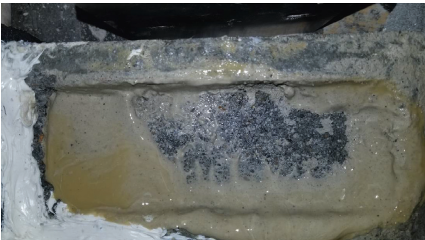
Figure 14: Final contact state of contact surface under a mixture of waste and bentonite slurries.